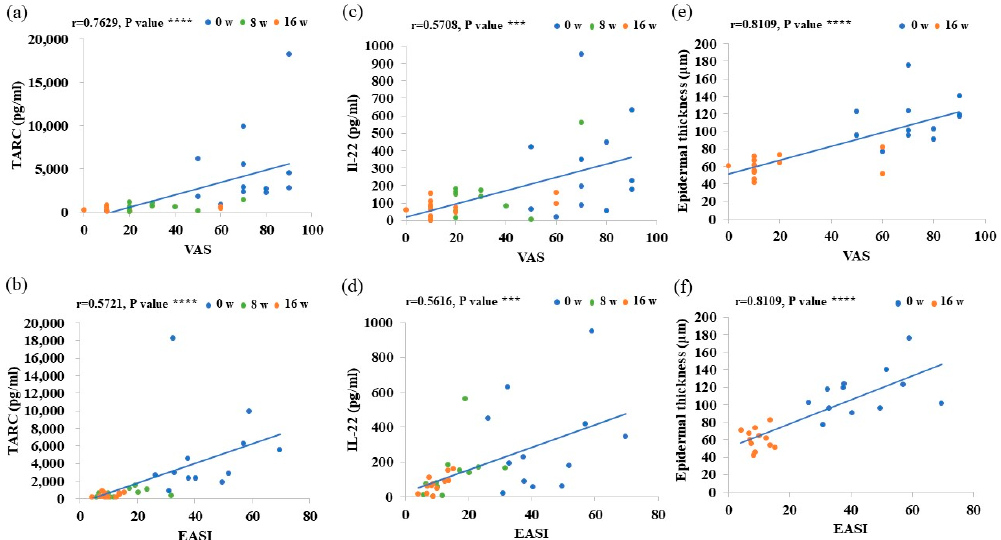
Figure 4. Correlation analysis of VAS and EASI scores with serum levels of TARC and IL-22 and epidermal thickness. ( a – f ) Correlation analysis of VAS and EASI scores with ( a , b ) serum TARC lev- els, ( c , d ) serum Il-22 levels, and ( e , f ) the degree of epidermal thickness. Data are shown as the mean ± standard error of the mean (n = 12 per group). Coefficients (r) were assessed by Spearman’s rank correlation test. *** p < 0.001. **** p < 0.0001.